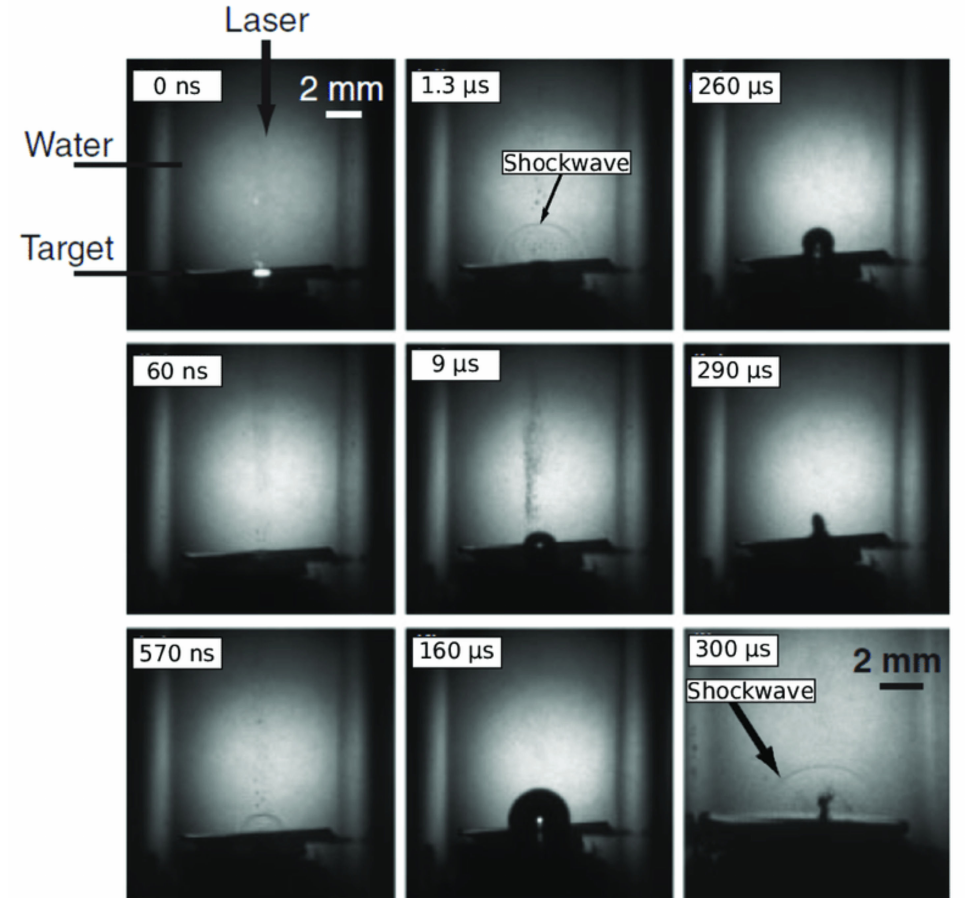
Figure 4. Shadowgraph images of pulsed laser ablation of Ag in liquid showing optical emissions at 0 ns, shockwave generation at 60 and 570 ns, and cavitation bubble motion (i.e., generation, shrinkage, and collapse) at 1.3–300 µ s. Adapted with permission from Ref. [81]. Copyright 2007, The Japan Society of Applied